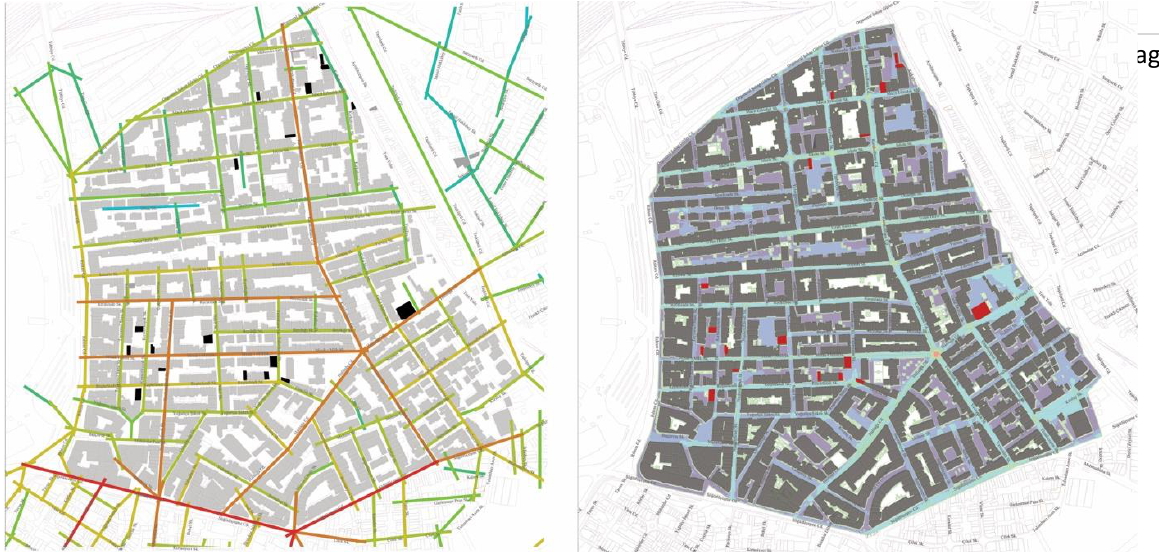
Figure 8 Maps of axial integration analysis (left) and the visibility pattern by Isovist analysis (right)